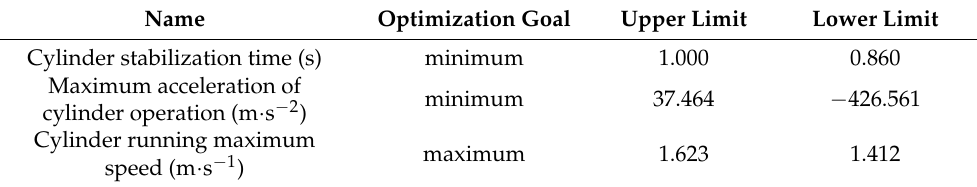
Table 6. Target parameter setting value.